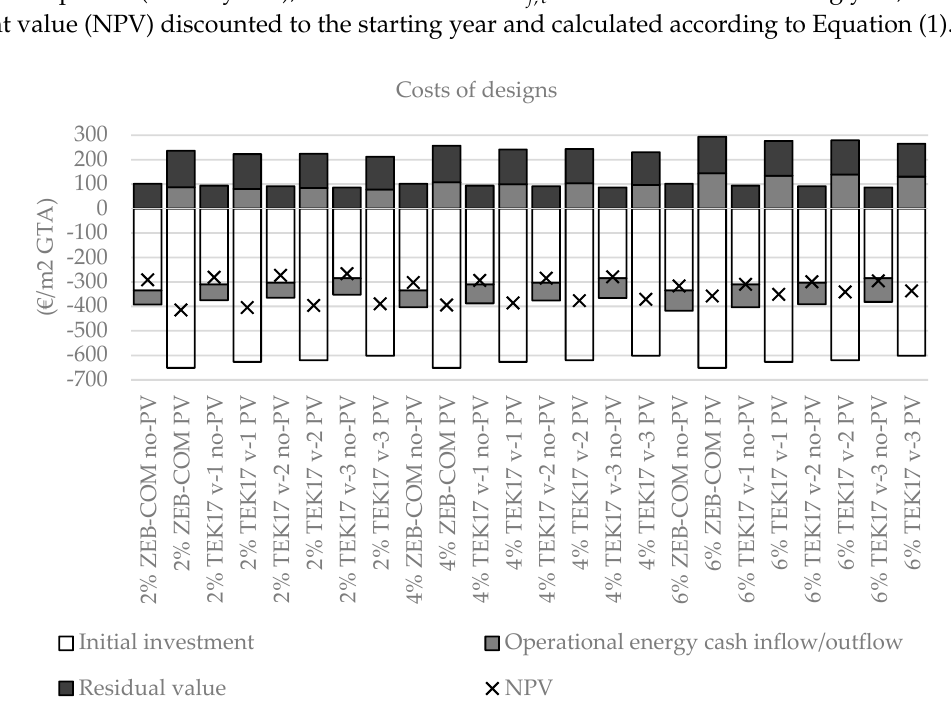
Figure 3. Initial investment costs, residual values, net present values, and sum of the annual costs of the four designs calculated with the 2%, 4%, and 6% electricity price increase scenario. All values are given for the solutions with and without the building integrated photovoltaic panel (BIPV) installed.